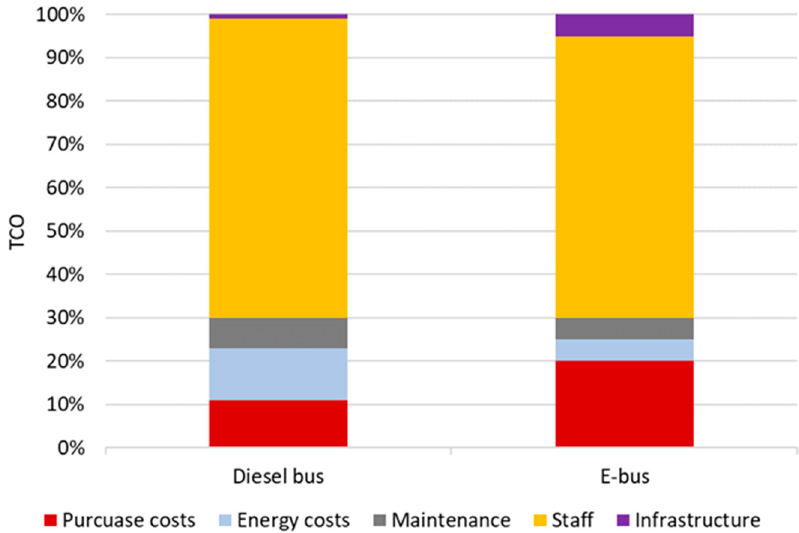
Figure 11. TCO for diesel and e-buses (Data source: [55], own analysis).